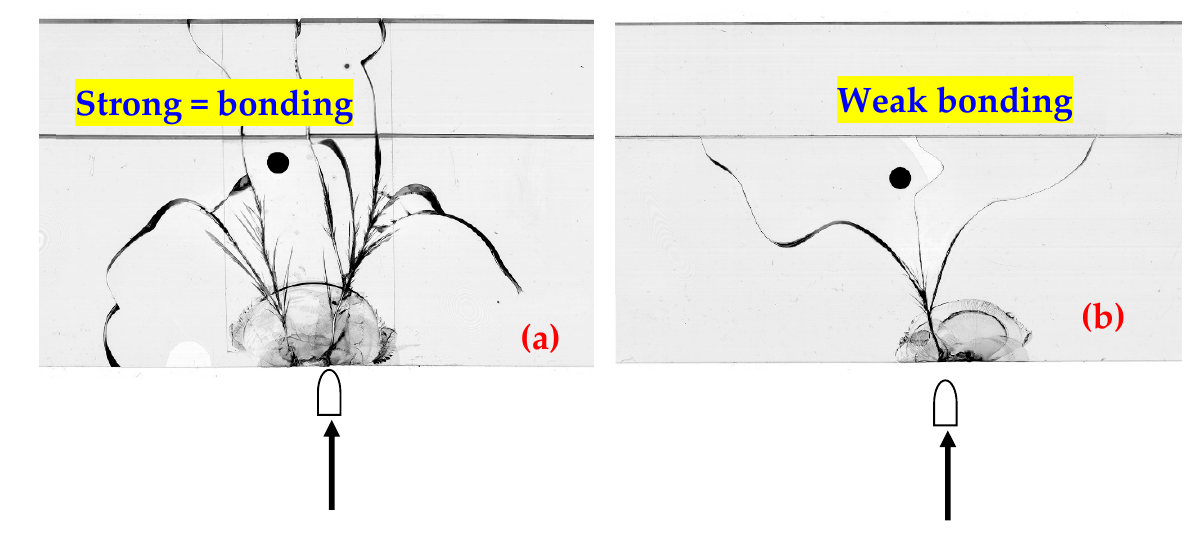
Figure 1. Post-mortem failure patterns of two identical brittle polymer specimens (Homalite-100) with different interfacial bonds subjected to the same gas gun impact with ( a ) 384 strong bonding and ( b ) 5083 weak bonding.